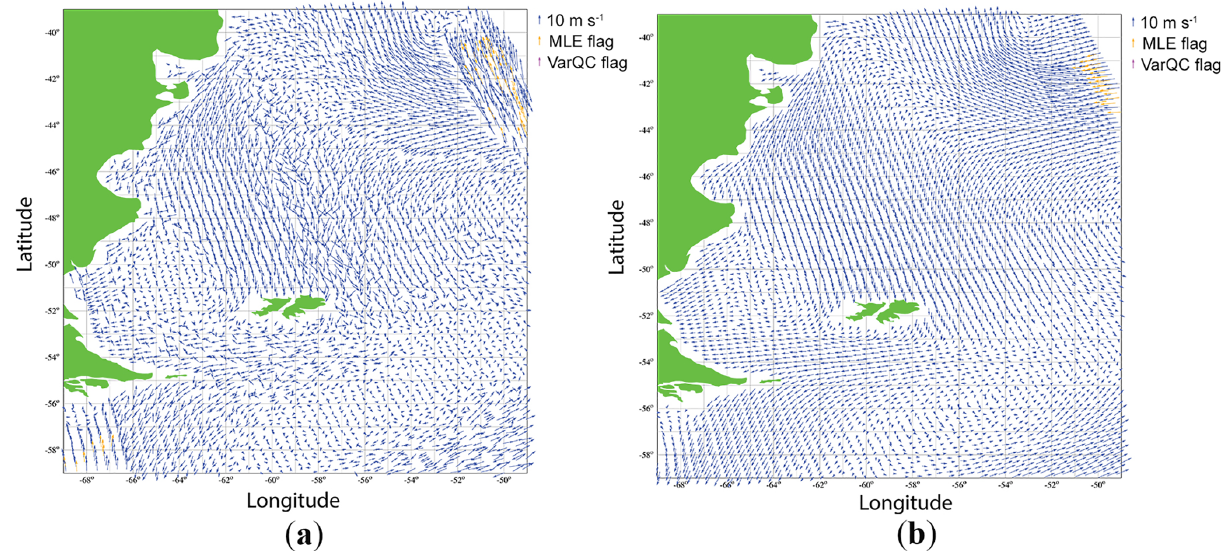
Figure 16. SeaWinds-retrieved wind field. (a) First rank solution. (b) 2DVAR result. The orange flags are artificial QC points and may be